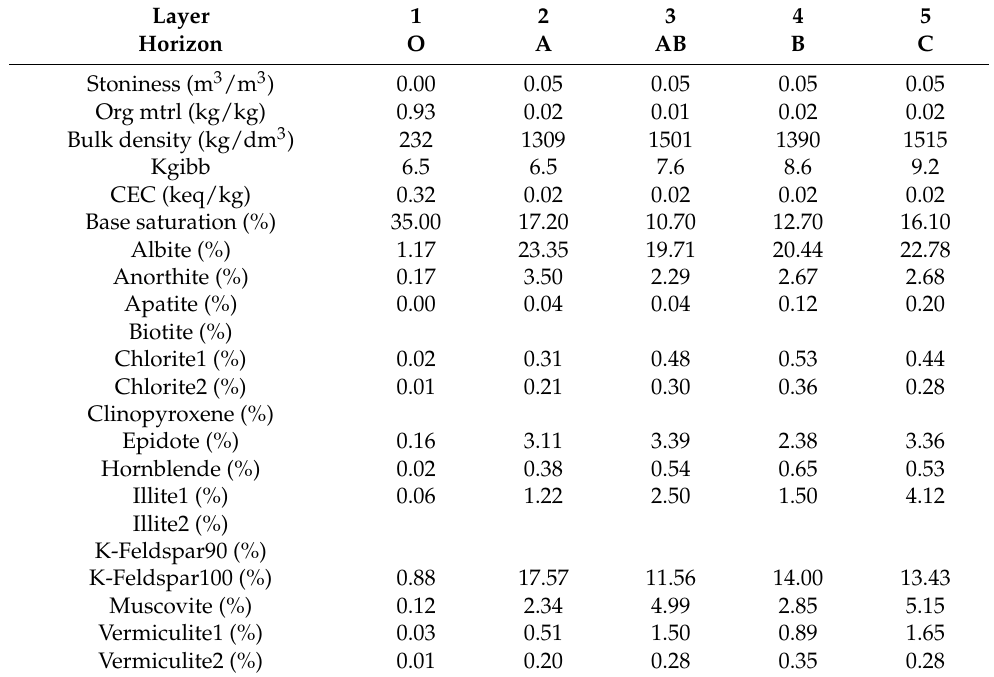
Table A4. Soil parameters for the Central site.